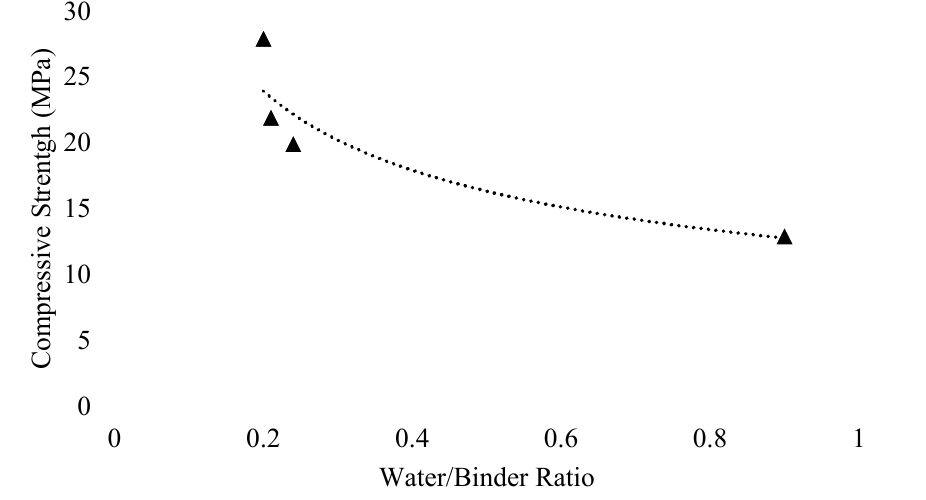
Figure 28. Relation between activator to binder (A / B) ratio and compressive strength at 2:1 fly ash / slag ratio, modified from [134], Elsevier, 2019.